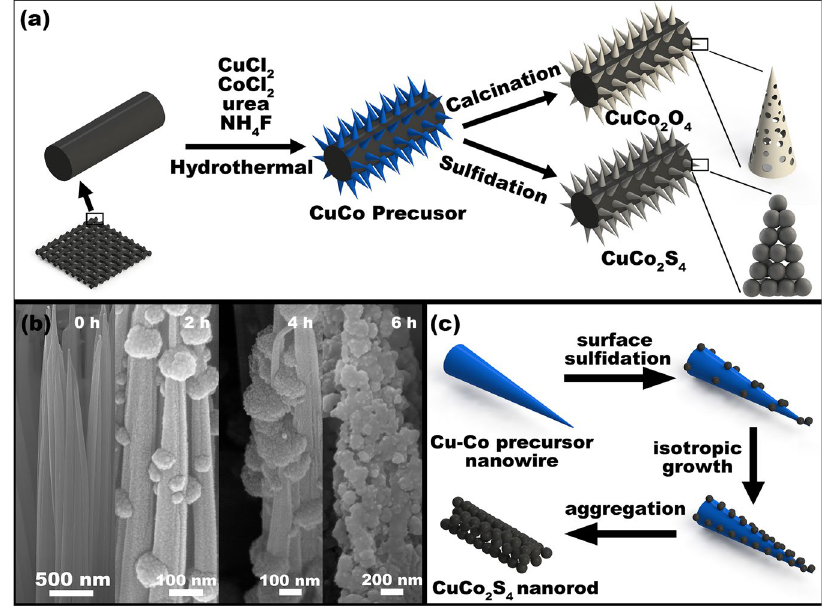
Figure 1. ( a ) Schematic illustration of the synthetic process of the CuCo 2 O 4 NWAs and the CuCo 2 S 4 NRAs on the carbon textile. ( b ) SEM images of the obtained samples over different sulfidation time. ( c ) Schematic illustration of the formation mechanism of the CuCo 2 S 4